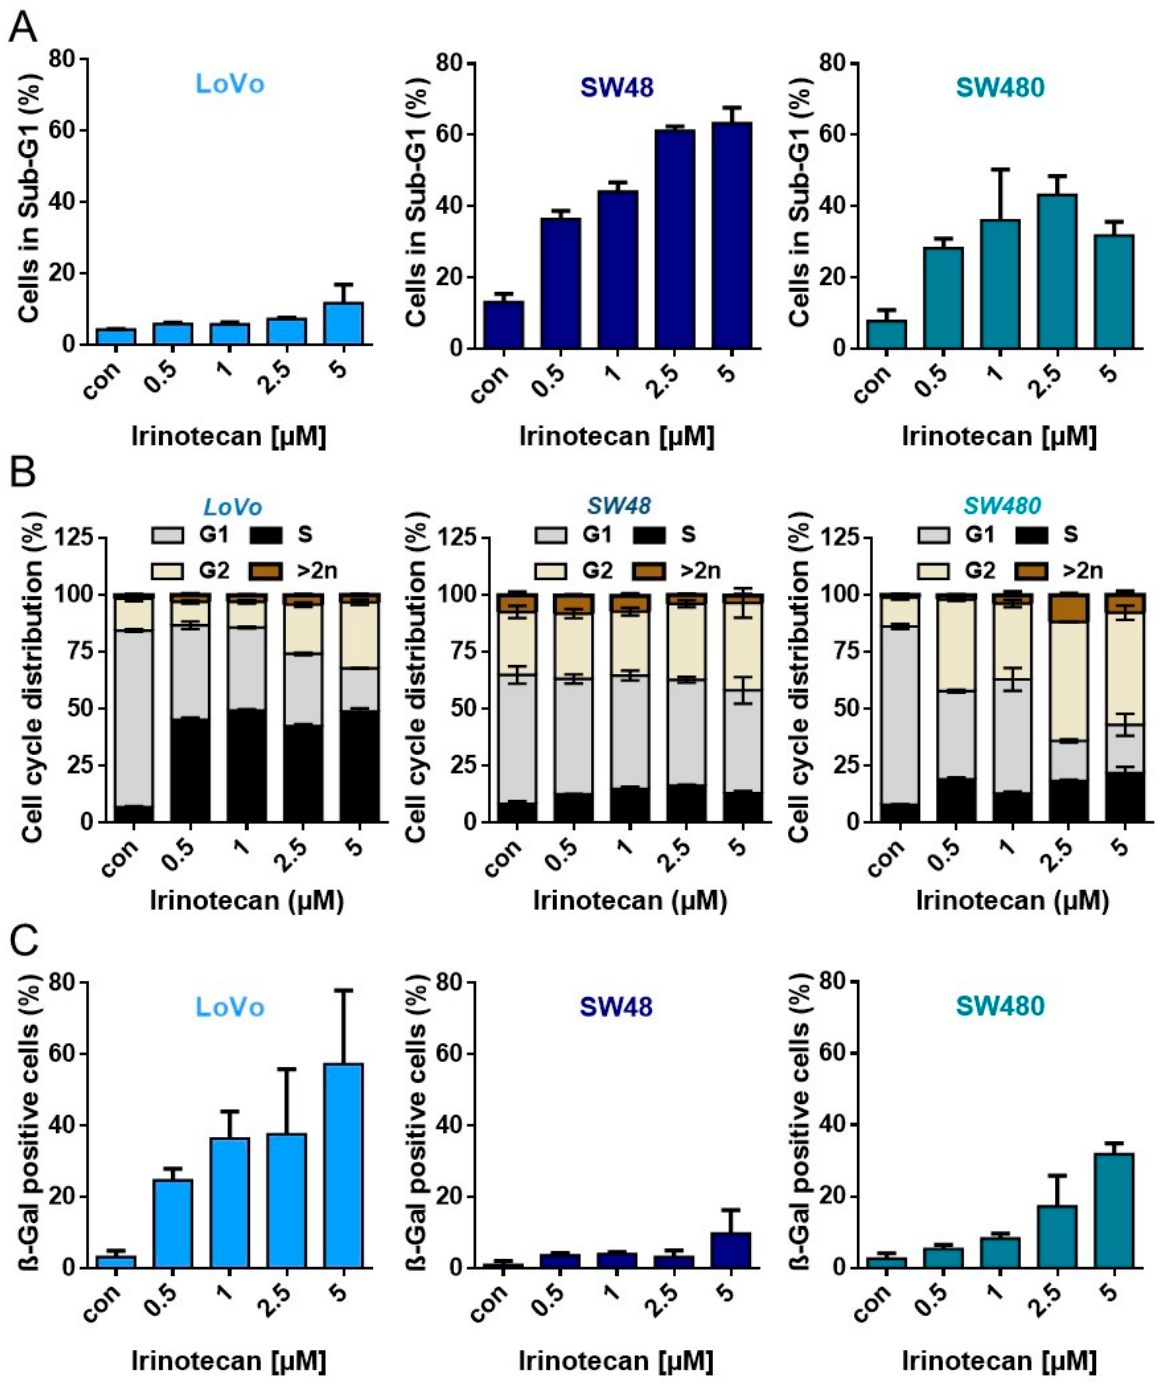
Figure A4. ( A ) Cell death was measured 168 h upon exposure to different concentrations of irinotecan by flow cytometry using PI staining in CRC cells. ( B ) Cell cycle distribution was measured 168 h upon exposure to different concentrations of irinotecan by flow cytometry using PI staining in CRC cells. ( C ) Senescence was measured microscopically by detection of β -Gal positive cells 168 h after irinotecan exposure.